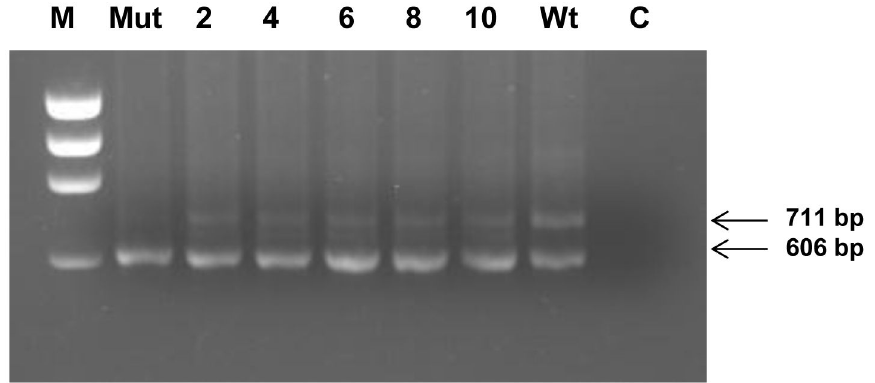
Figure 3. Analysis of morpholino treatment: RT-PCR from minigene-transfected morpholino-treated Oli-neu cells. RNA was extracted from cells transfected with the wild-type (Wt) and mutant (c.436C>G) minigene constructs (Mut, 2, 4, 6, 8, 10). Samples 2, 4, 6, 8 and 10 were treated with the morpholino oligonucleotide, whereas samples Mut and Wt were untreated. Treated cells received 10 mM morpholino oligonucleotide in 2, 4, 6, 8, 10 mM Endoporter reagent; lane C: no template control; lane M: φX174 DNA Hae III restricted molecular weight marker. The minigene-specific primer 31GF/LACT2R-mediated RT-PCR products are 711 bp (PLP product) and 606 bp (DM20 product) in length, respectively.